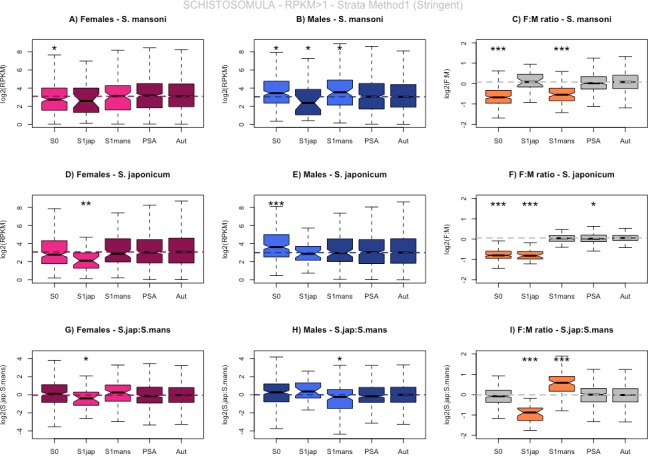
Schistosomula expression patterns (RPKM>1, stringent strata) of genes located in the different strata of the Z (S0, S1man and S1jap), as well as pseudoautosomal and autosomal genes.The distribution of expression values is shown for (A) S. mansoni females, (B) S. mansoni males, (C) S. mansoni female:male, (D) S. japonicum females, (E) S. japonicum males, (F) S. japonicum female:male, (G) Female expression in S. japonicum divided by female expression in S. mansoni, (H) Male expression in S. japonicum divided by male expression in S. mansoni, (I) female:male ratio of expression in S. japonicum divided by female:male ratio of expression in S. mansoni. Asterisks represent levels of significance of comparisons to the control autosomal genes (*p-value<0.05, **p-value<0.001, ***p-value<0.0001). Genes previously mapped to the ZW linkage group were assigned to each Z-chromosome stratum based on their coverage patterns (stringent classification); only genes with RPKM >1 were used.